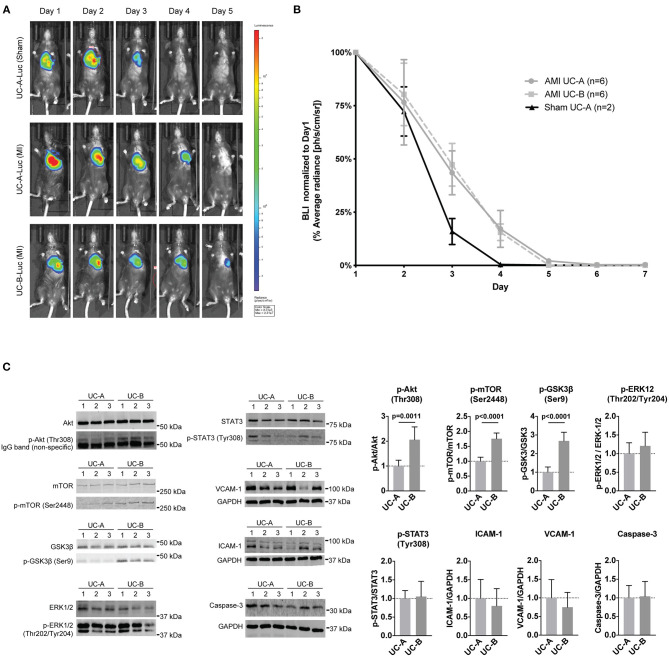
UCM-MSC delivered into the LV show similar engraftment following myocardial infarction (MI) but differentially activate signaling pathways. (A) Representative images of time-course bioluminescence detection of luciferase expressing UC-A and UC-B delivered into the LV tissue after MI. (B) Average radiance determined in the thoracic cavity area using equivalent regions of interest for all animals in the study. Data shown as Average radiance ±SEM normalized to measurements of each animal at day 1. (C) Western-blot analysis of the LV borderzone at day 2 post MI and UCM-MSC myocardial delivery (blots shown for 3 animals per group; n = 6 per study group).